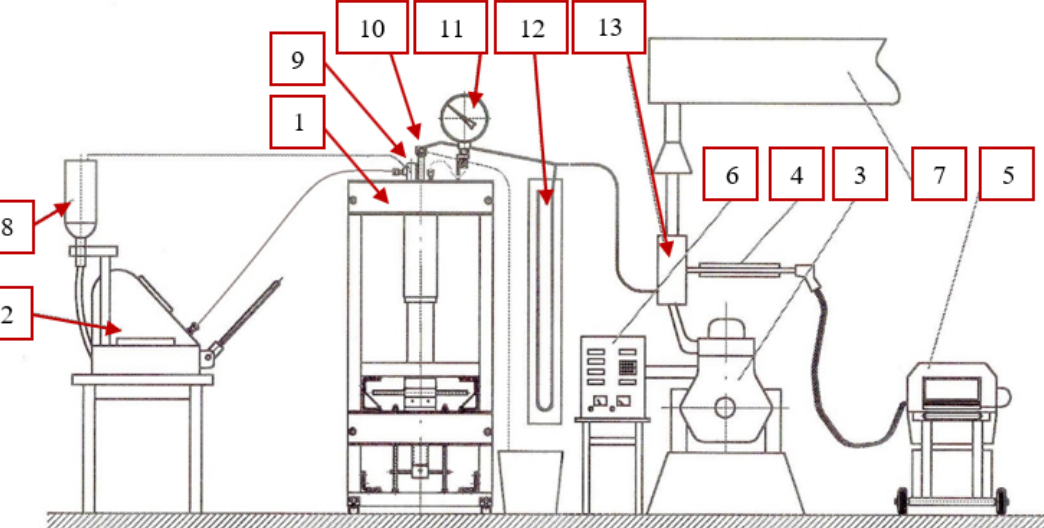
Figure 4. Diagram of the diesel fuel/exhaust gas compressibility measurement stand: 1—frame with hydraulic actuator, 2—probe (pumping section of the injection pump), 3—combustion engine, 4—exhaust gas analyzer probe, 5—exhaust gas analyzer, 6—control panel, 7—extraction system, 8—fuel tank, 9—injector, 10—valves (exhaust, supply and bleed valves), 11—manometer, 12—U-pipe, 13—exhaust gas system.